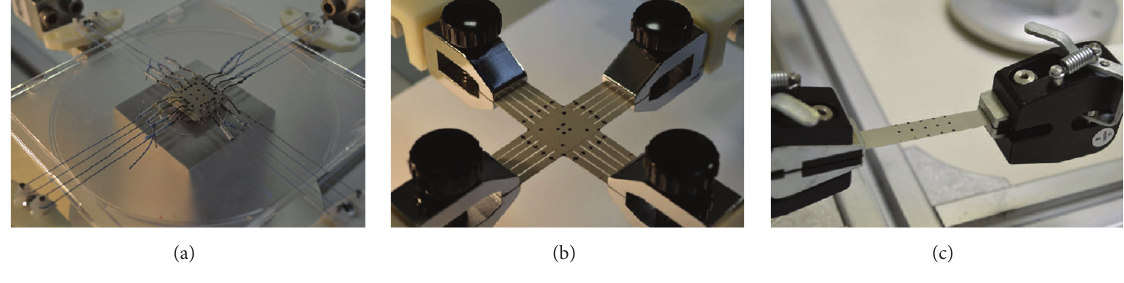
Figure 2: Different mounting options: hooks (a), screw clamps (b), and wedge grips (c).